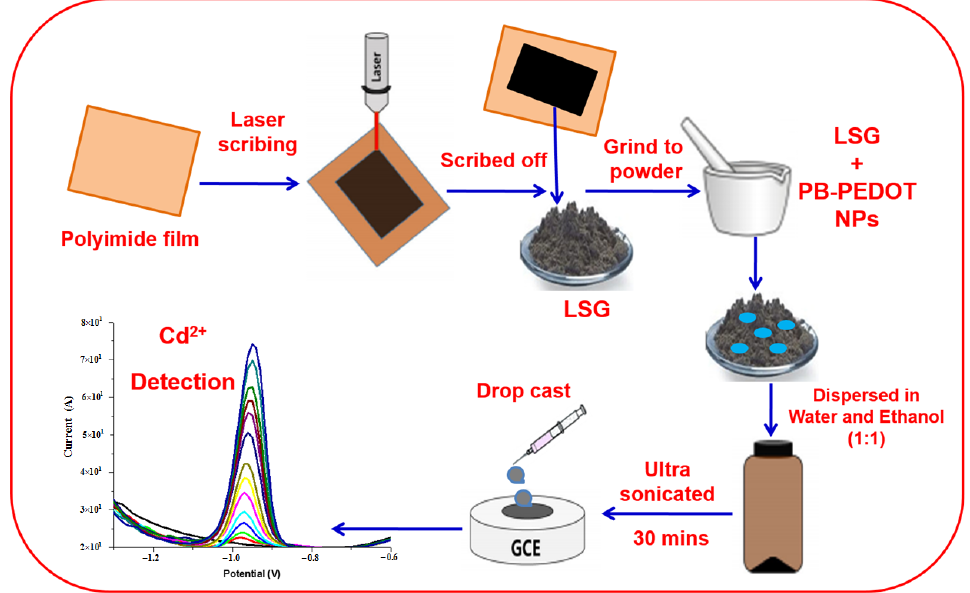
Figure 1. Schematic representation of the fabrication of LSG and the synthesis of PB-PEDOT nanoparticles for cadmium ion sensing.